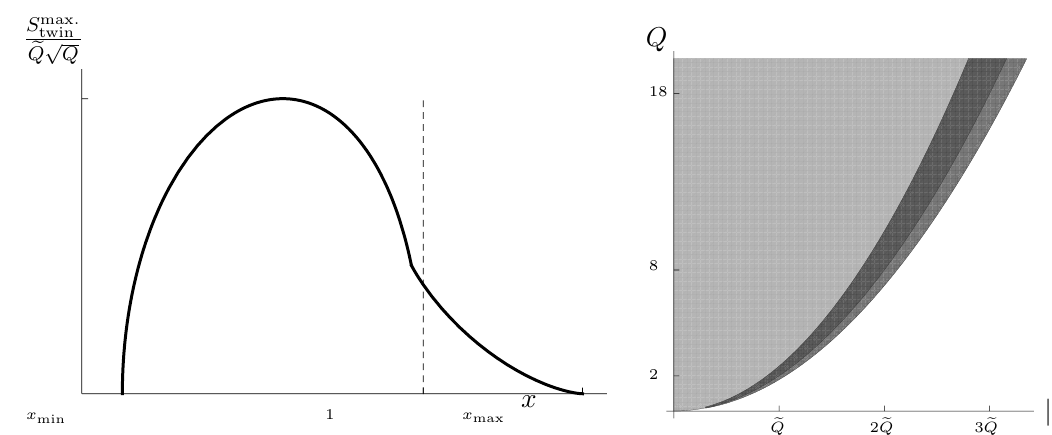
Figure 4 . Left plot: maximum of the entropy as a function of J , for (cid:12)xed values of Q; e Q . Here p p p x min = 7 2 = 5 5 and x max = 3 = 2 2 . The dashed vertical line represents the maximum value of the spin for the BMPV black hole. Right plot: region where the twin black hole solution exists (dark gray) in the ( J ; Q ) plane, for a (cid:12)xed value of e Q . In the light gray region only the BMPV black hole exists. In the darkest region in the middle the two solutions